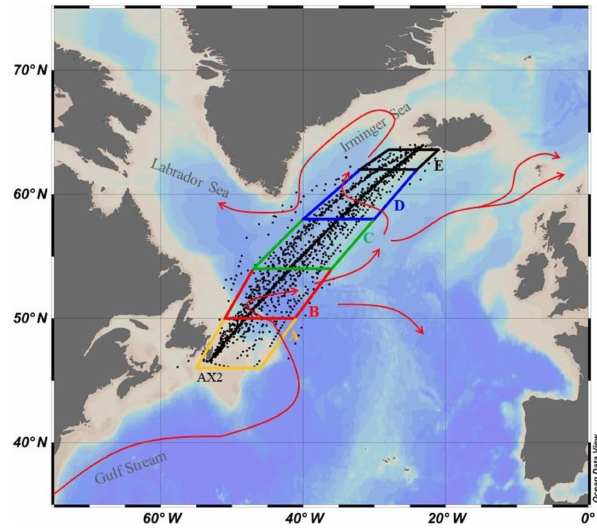
Figure 1. SURATLANT cruise tracks (in black, TA–DIC data over the period 1993–2017) with the five boxes (box A: 46–50 ◦ N (in yellow), box B: 50–54 ◦ N (in red), box C: 54–58 ◦ N (in green), box D: 58–62 ◦ N (in blue), box E: 62–64 ◦ N (in black)) and surface cur- rents in the North Atlantic Subpolar Gyre (NASPG) circulation re- sulting from the Gulf Stream and the North Atlantic Current (in